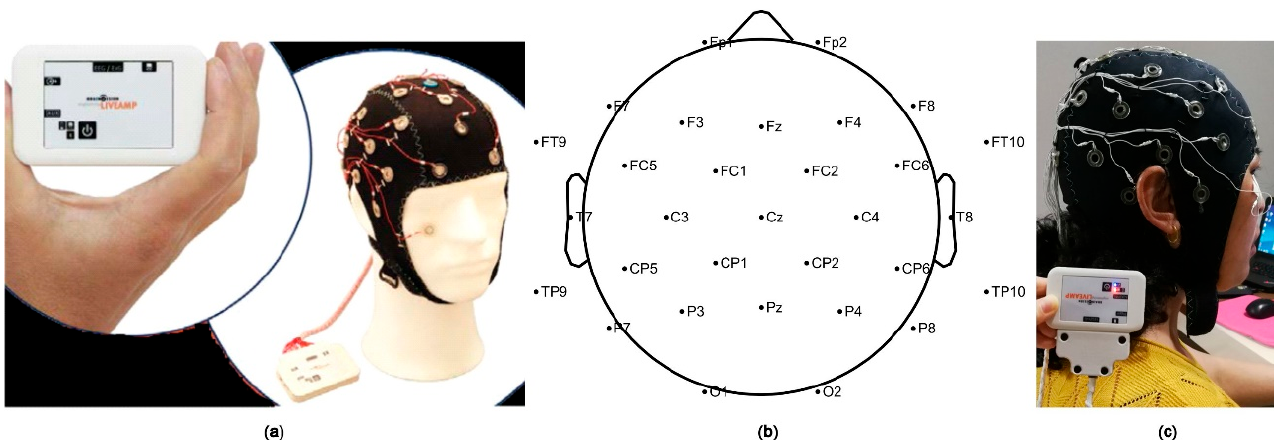
Figure 2. ( a ) Brain Products (LiveAmp) device with 32 channels used in the experiment; ( b ) electrode distribution in brain region; ( c ) example of a volunteer.